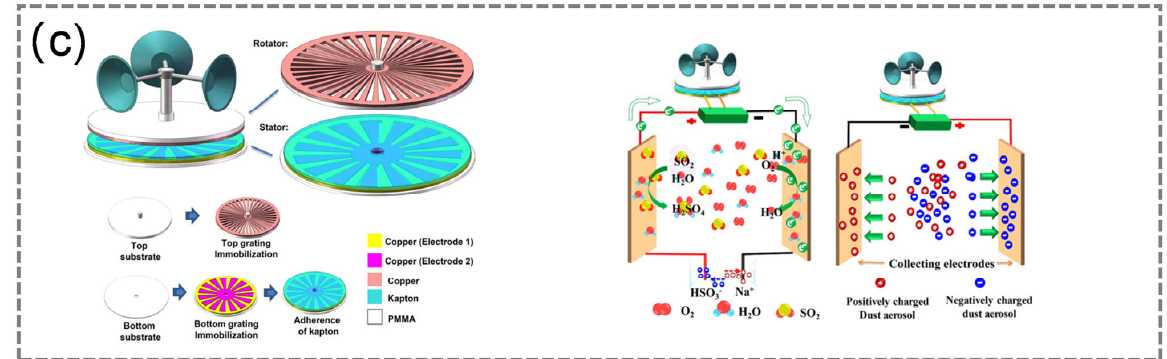
Figure 8. Applications enabled by WD ‐ TENG: ( a ) wind energy collection network based on TENGs (reproduced with permission [65]. Copyright 2019, Nano Energy ). ( b ) Self ‐ powered sensor system for detecting wind speed and direction (reproduced with permission [66]. Copyright 2018, ACS Nano ). ( c ) Self ‐ powered air purification system (reproduced with permission [73]. Copyright 2015, Nano Energy ).